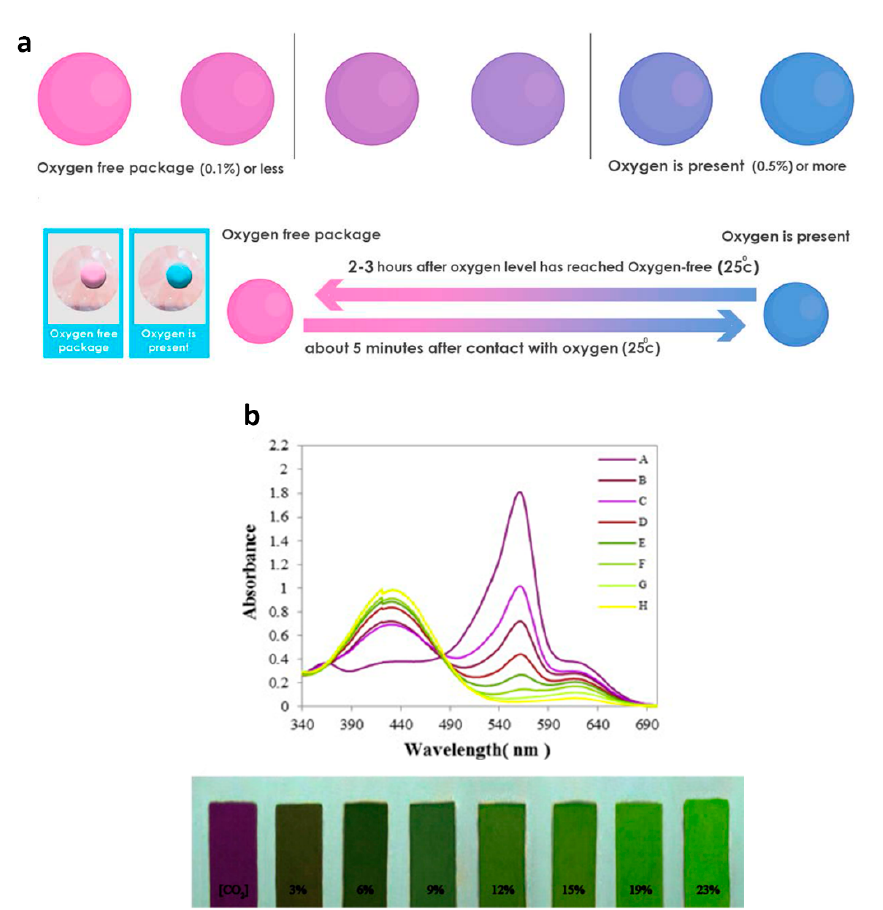
Figure 1. ( a ) O 2 sensors based on a colorimetric redox dye. Reproduced with permission from [7]. Copyright © 2019 American Chemical Society. ( b ) Label color changes in response to CO 2 . Adapted with permission from [85]. Copyright © 2014 Elsevier B.V. All rights reserved.